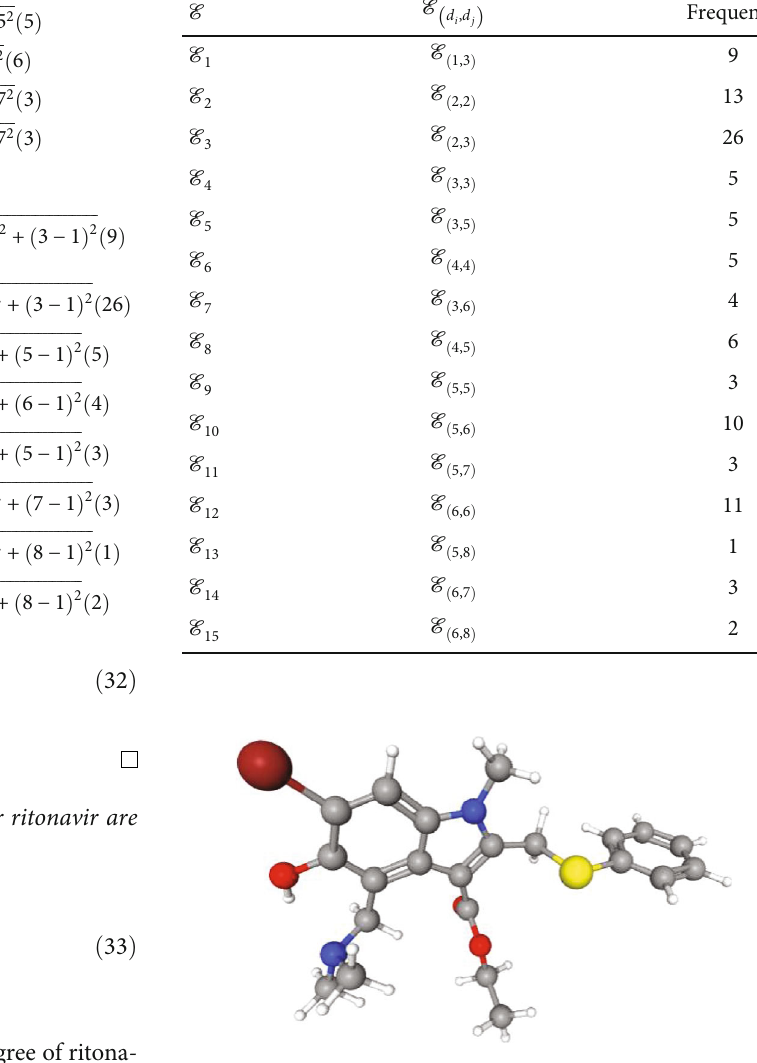
Figure 11: Molecular structure of